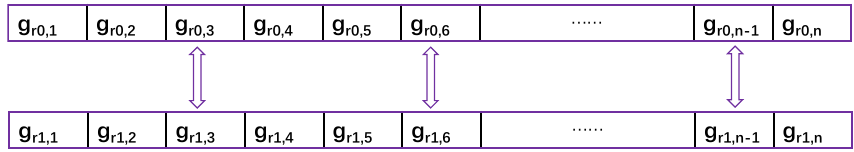
Figure 5. Paternal gene crossover process.